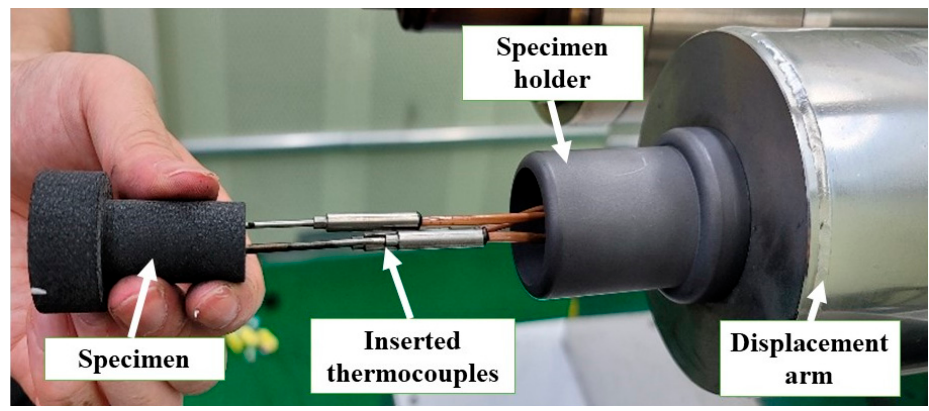
Figure 6. Specimen with inserted thermocouples.